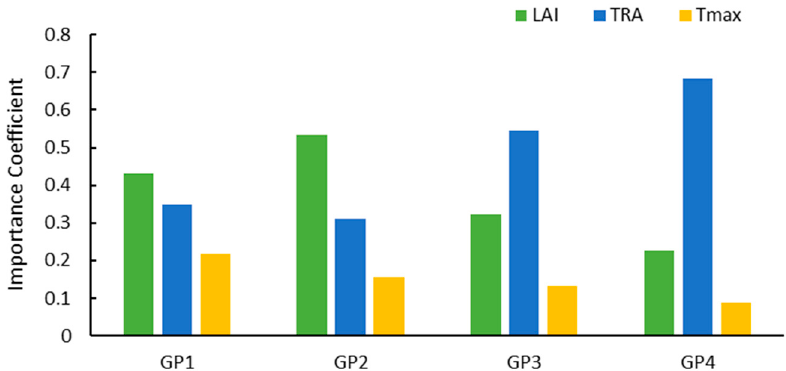
Figure 8. Results of Feature Importance Analysis.